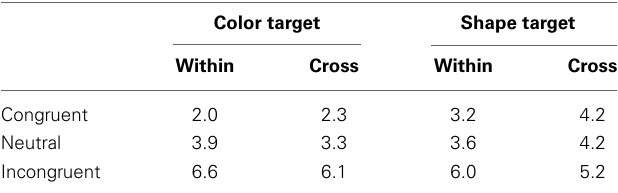
Table 2 | Error rates (in percentage) in Experiment